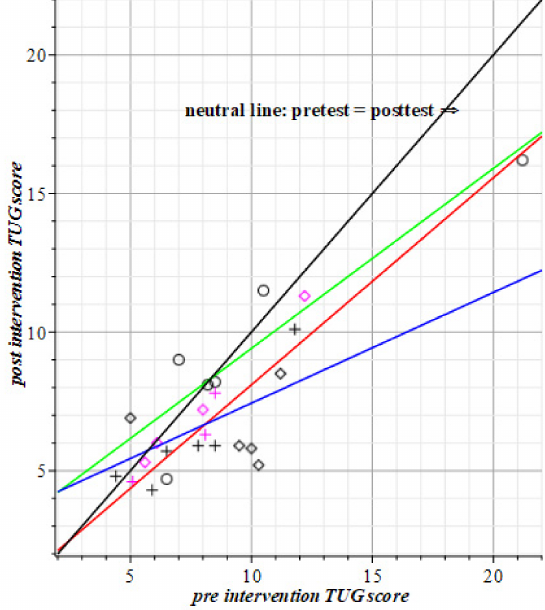
Figure 6. The mean results of the motor intervention are green; the visuo-spatial-motor intervention mean line is blue; the red line is the control group; the no-results, or neutral line is black. All groups are below the black line, so they all made progress, compared to their respective pre-intervention scores. The visuo-spatial-motor group performs the fastest (in the mean). Red datapoints represent male subjects. Circles and green line: Motor group, T 1 = 2.92 ( ± 1.60) + 0.65 ( ± 0.14) T 0 ( TUG ) . Rhombus pts., blue: Visuo-spatial-motor group, T 1 = 3.44 ( ± 2.17) + 0.40 ( ± 0.24) T 0 ( TUG ) . Plus signs, red line: Control group, T 1 = 0.63 ( ± 0.94) + 0.75 ( ± 0.12) T 0 ( TUG )